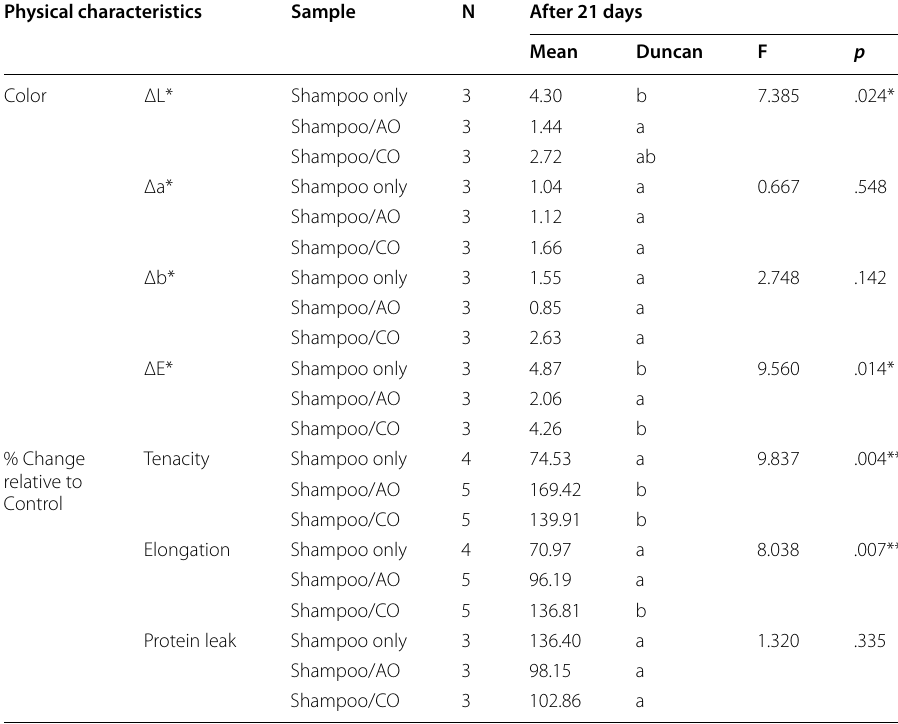
Table 11 Analysis of Variance test on the change of physical characteristics of bleached hair after 21 days of shampoo with or without the use of Argan oil (AO) or Camellia oil (CO) conditioners Physical characteristics Sample